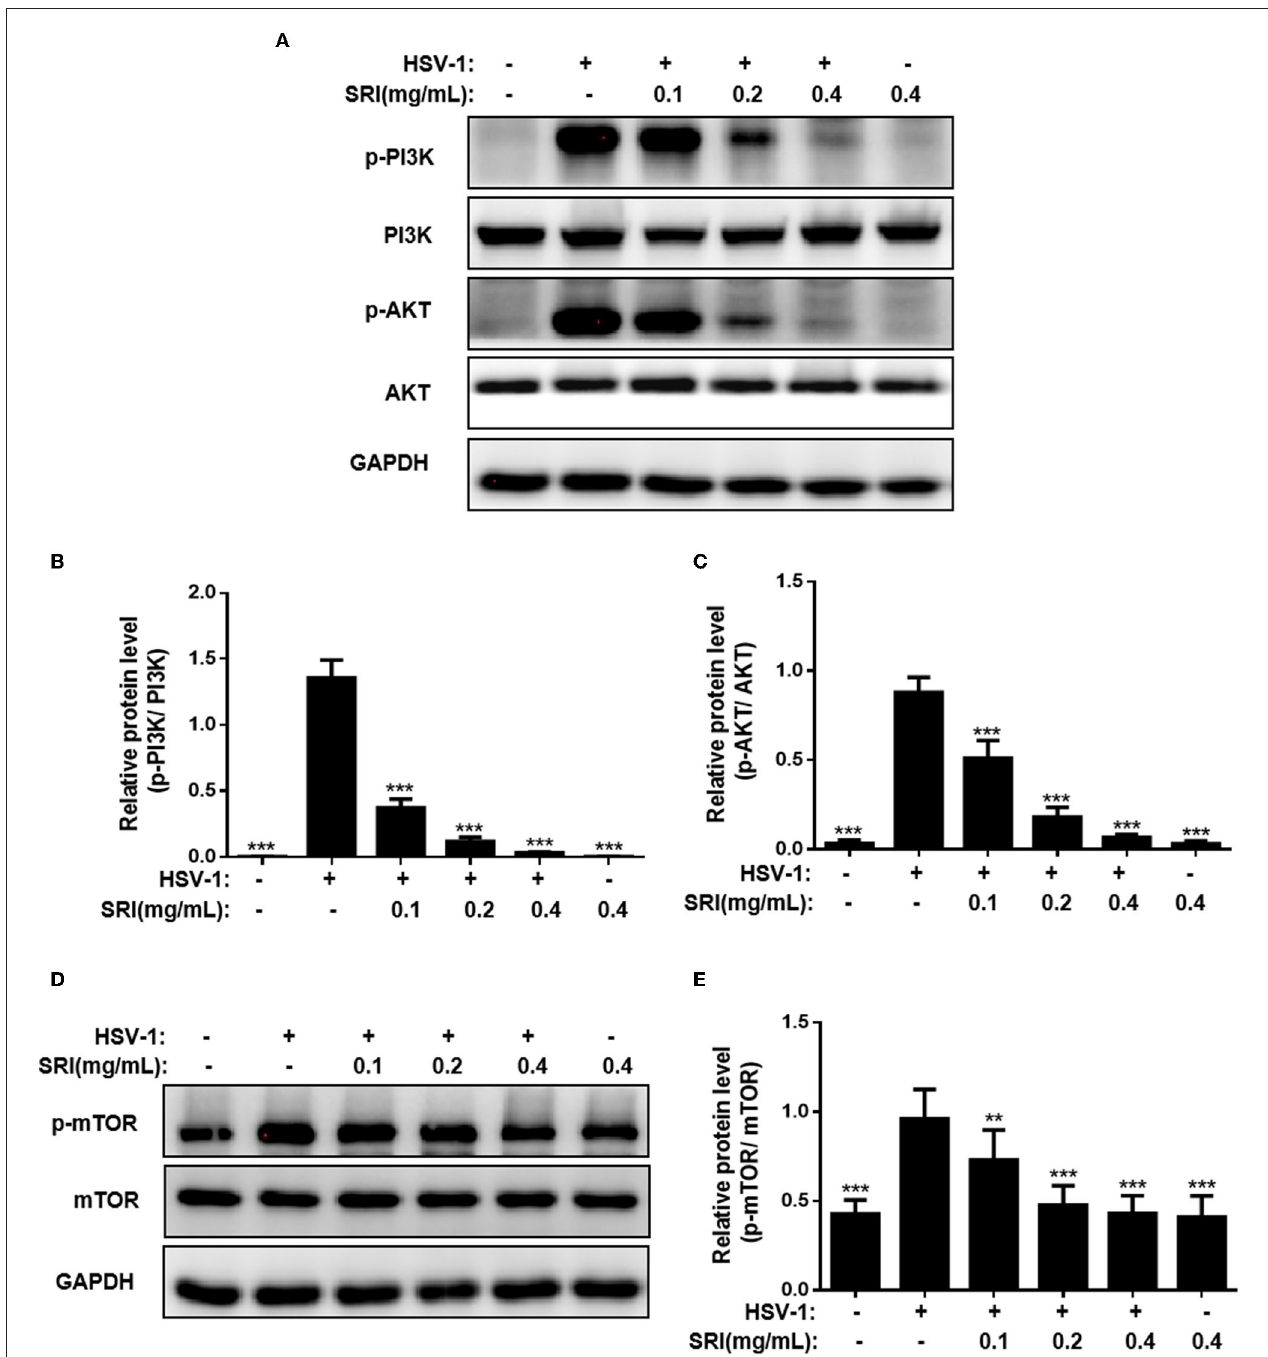
FIGURE 6 | SRI inhibited HSV-1 replication through blocking of PI3K/Akt pathway. (A–E) The infected cells of HSV-1 (MOI = 1) were treated with or without SRI (0.1, 0.2, and 0.4 mg/mL), and the protein levels of p-PI3K, PI3K, p-Akt, and Akt were evaluated using Western blotting analysis. Blots were also probed for GAPDH, which was used as a loading control. Plots quantifying the immunoblots as ratios for p-PI3K/PI3K (B) , p-AKT/Akt (C) , and p-mTOR/mTOR (E) , respectively. The results shown are representative of three independent experiments. The results are presented as mean ± SD values. ** p < 0.01 and *** p < 0.001 vs HSV-1 group; ns, not